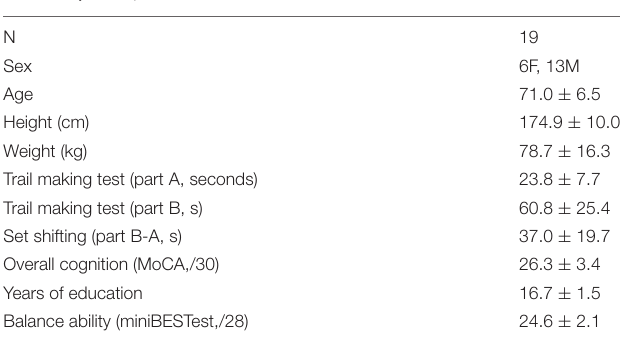
TABLE 1 | Participant characteristics.